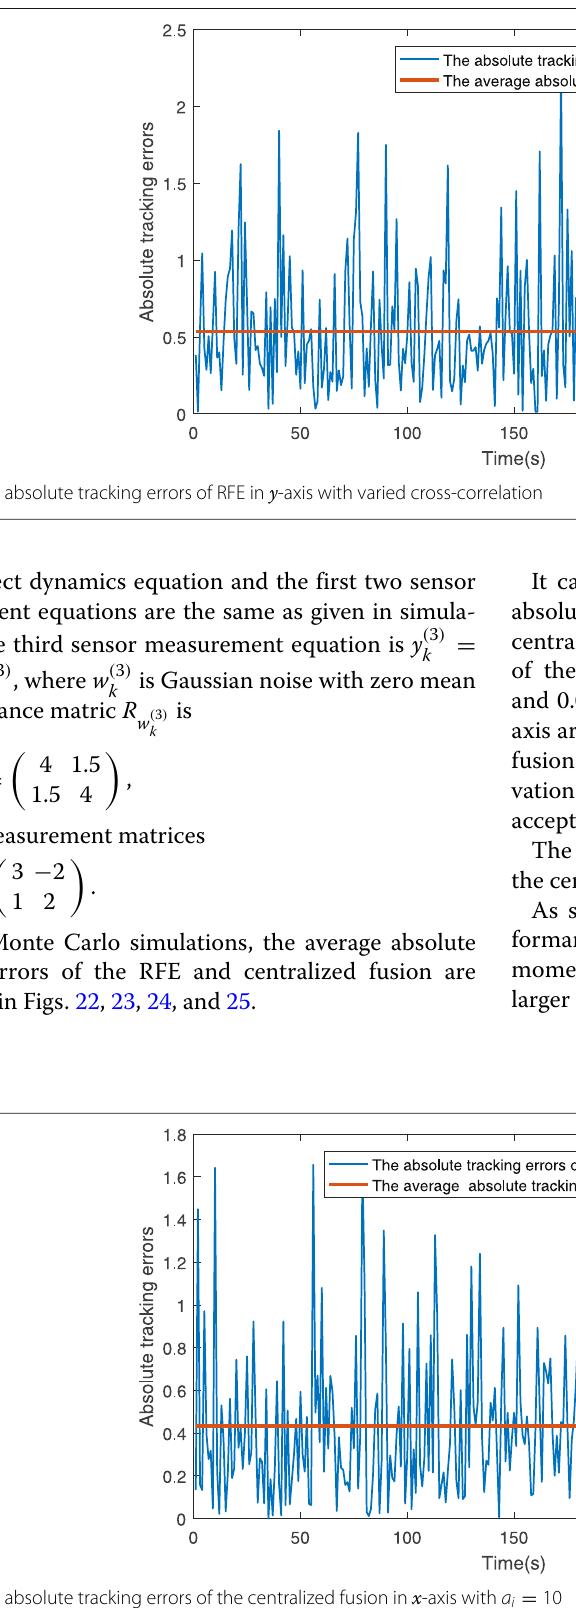
Fig. 22 The absolute tracking errors of the centralized fusion in x -axis with a i =